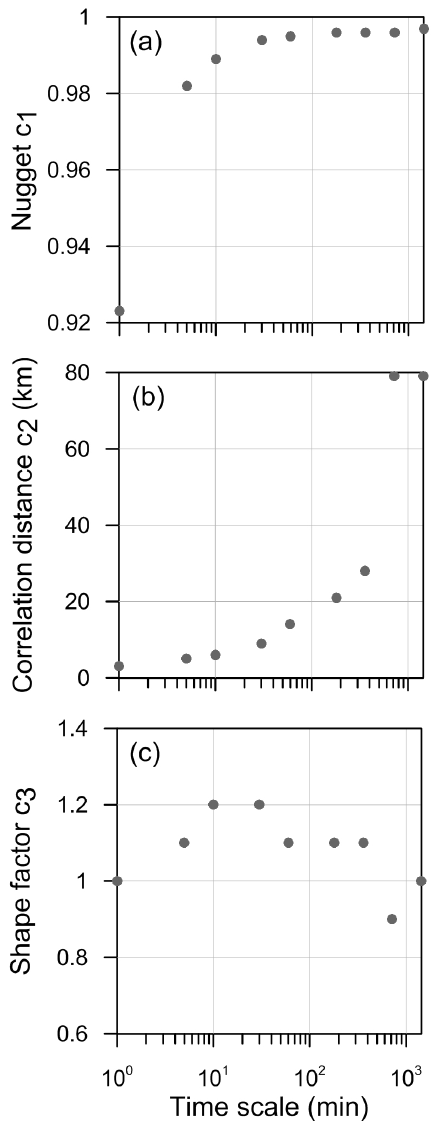
Fig. 4. Time-scale dependence of the nugget (a) , correlation dis- tance (b) and shape factor (c) used in the three-parameter exponen- tial